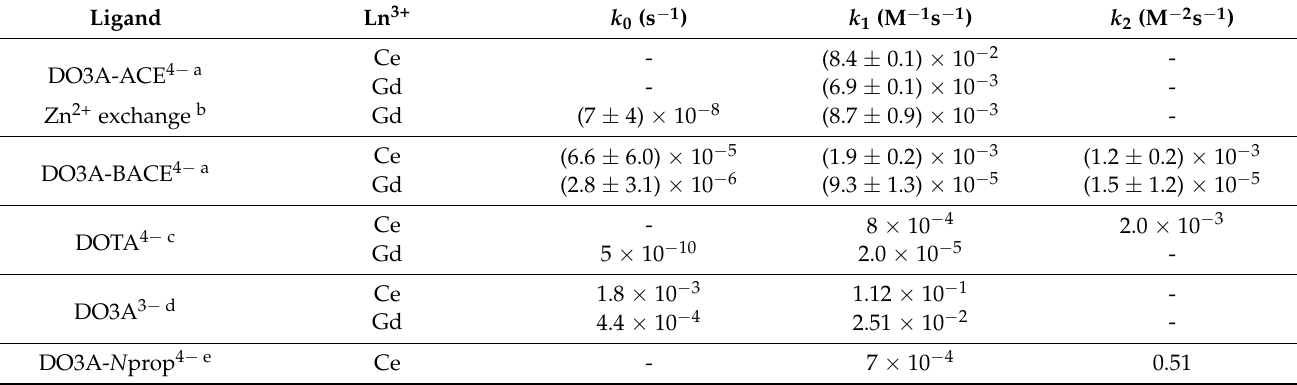
Table 5. Comparison of the rate constants of spontaneous and acid catalyzed dissociation for various Ce 3+ and Gd 3+ complexes, and for the exchange reaction of Gd(DO3A-ACE) − with Zn 2+ (25 ◦ C).